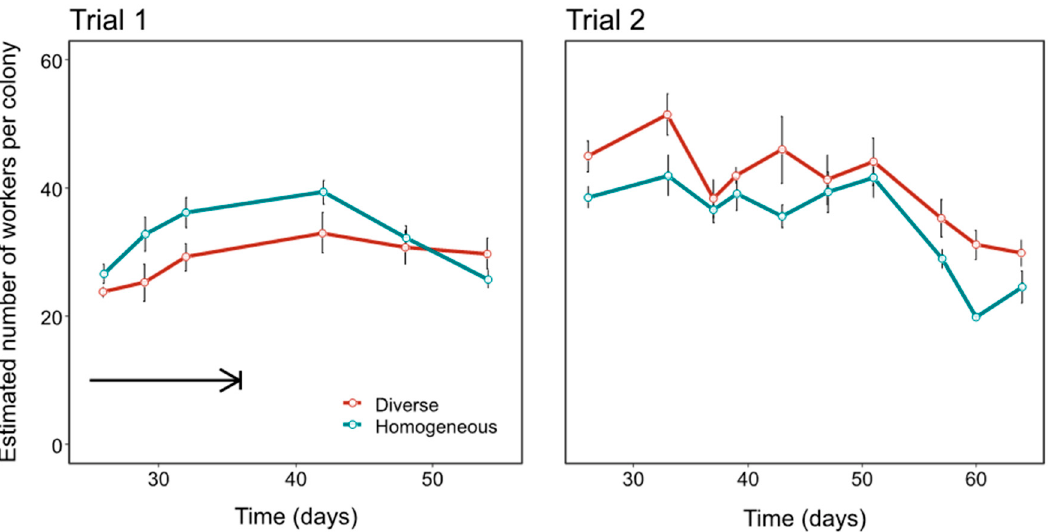
Figure 3. Estimated number of workers per colony over time from colony censuses. The plots show mean (±SE). Thick black arrow indicates a period in Trial 1 when workers during which introduced depending on mortality levels in an attempt to keep colony size similar between treatments at this stage (there was no corresponding period in Trial 2). Other than this period, workers were introduced in equal numbers and so differences in colony size reflect differences in worker mortality. See Methods for additional details on census procedure and statistics.